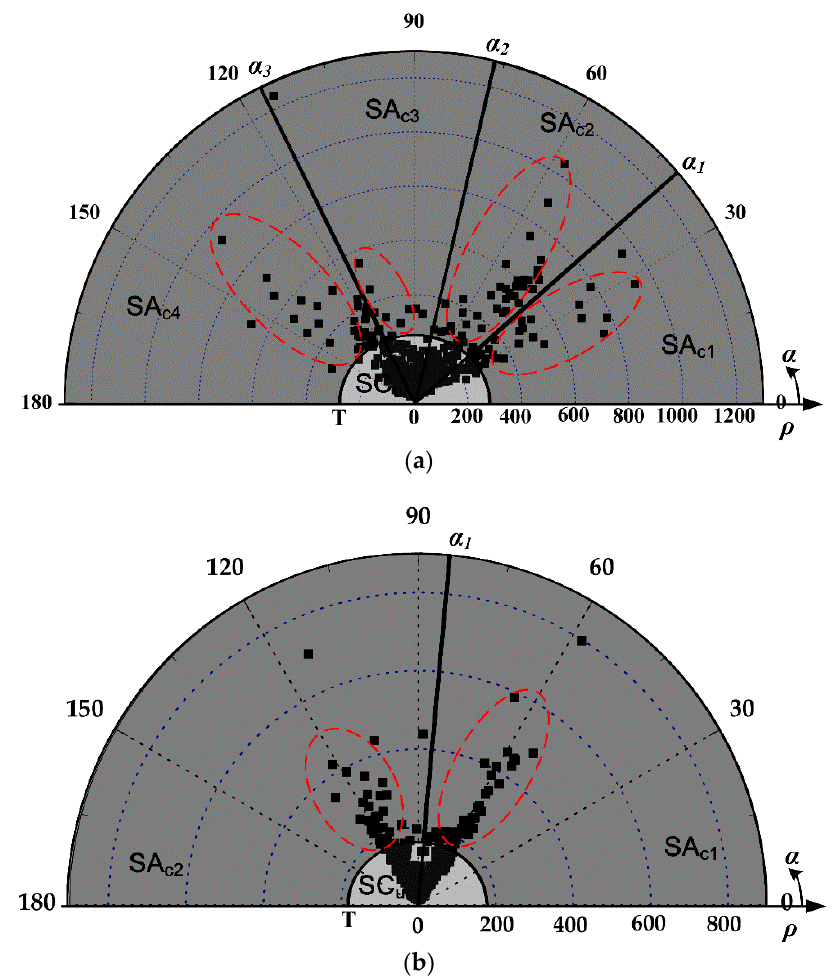
Figure 8. The scattergram in the polar representation for ( a ) the proposed SAW-CVA approach and ( b ) the standard CVA approach. ( b ) the standard CVA